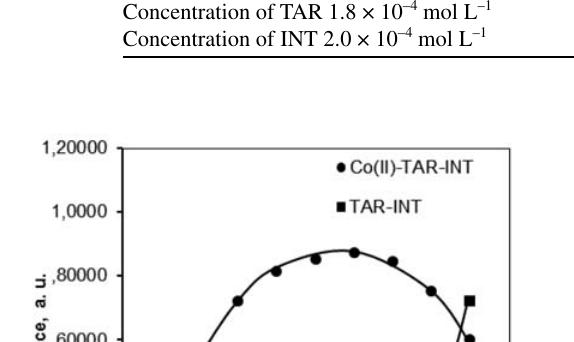
vs. pH of the aqueous pha- 3